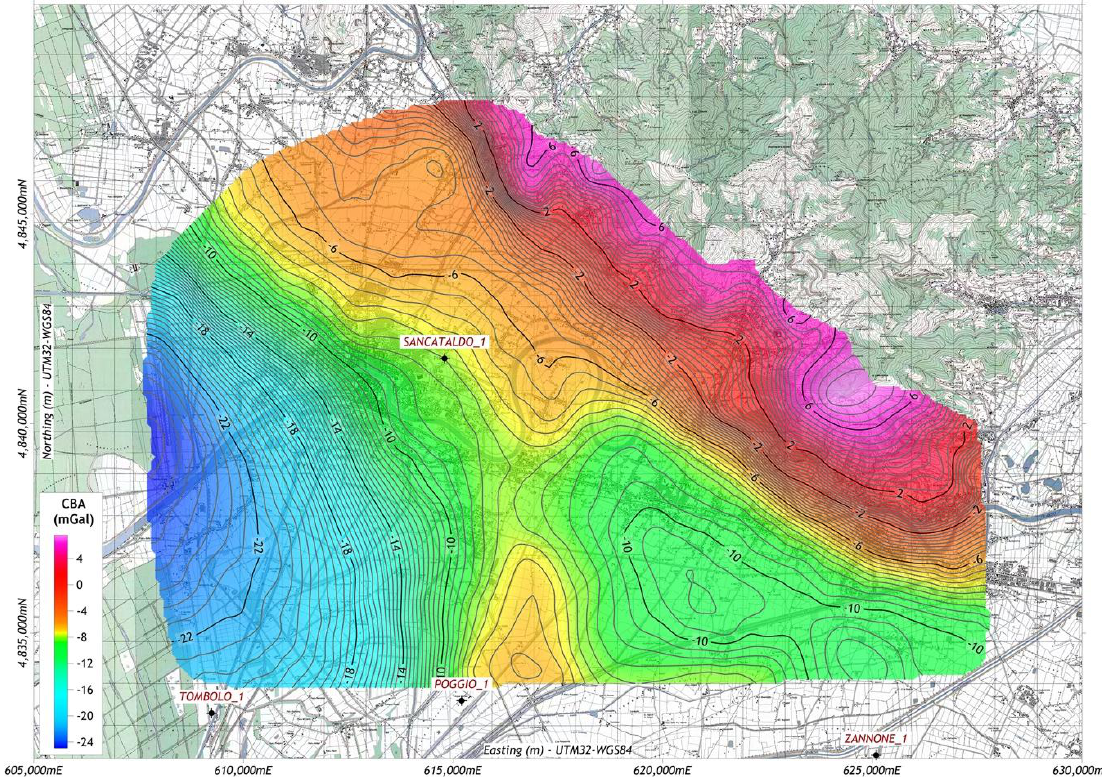
Figure 4. Gravimetric survey of the Pisa plain: Bouguer anomaly map, after residualization.